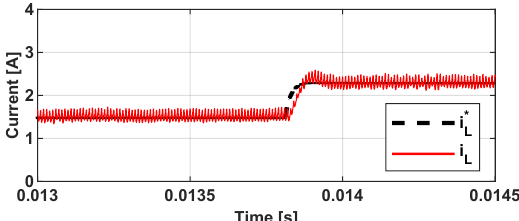
Figure 9. Step response of the current i L using the predictive controller.